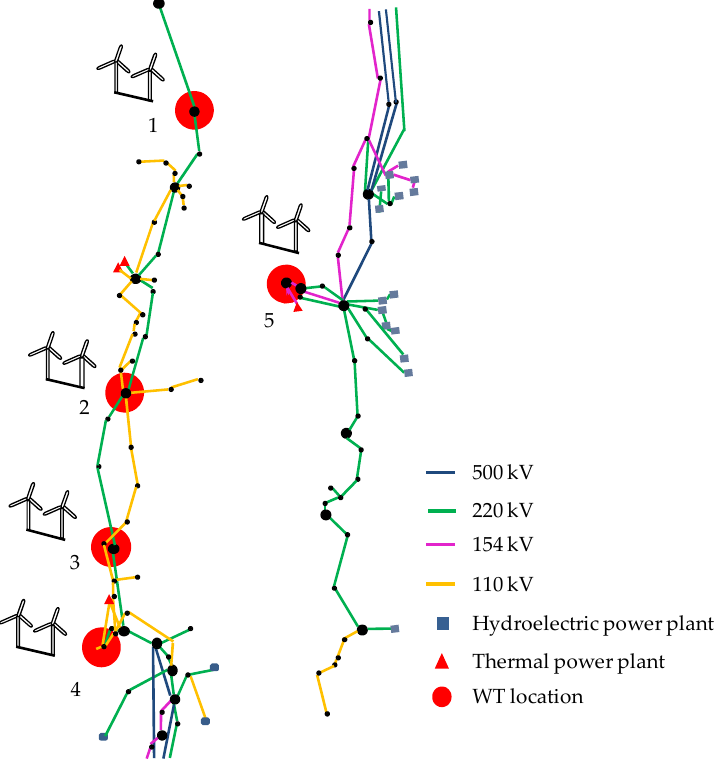
Figure 2. Schematic of the Chilean transmission